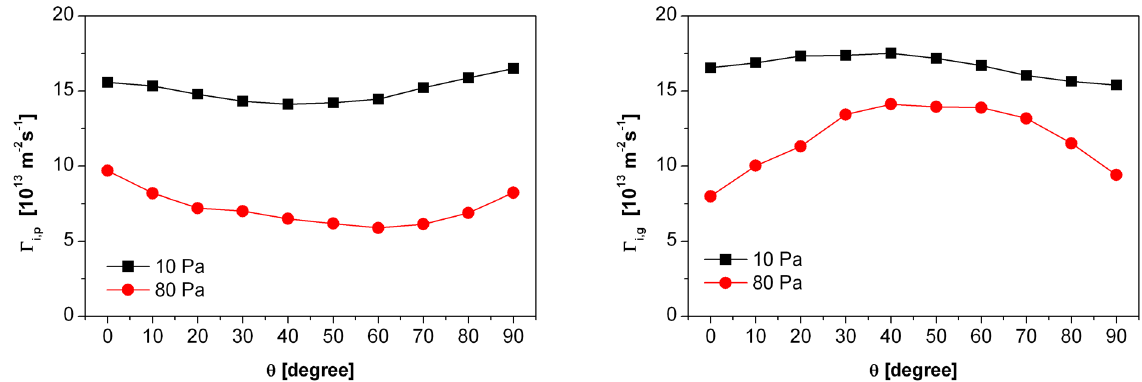
=Φ = 100 V and at 80 Pa, Φ =Φ = 50 V. LF HF LF HF